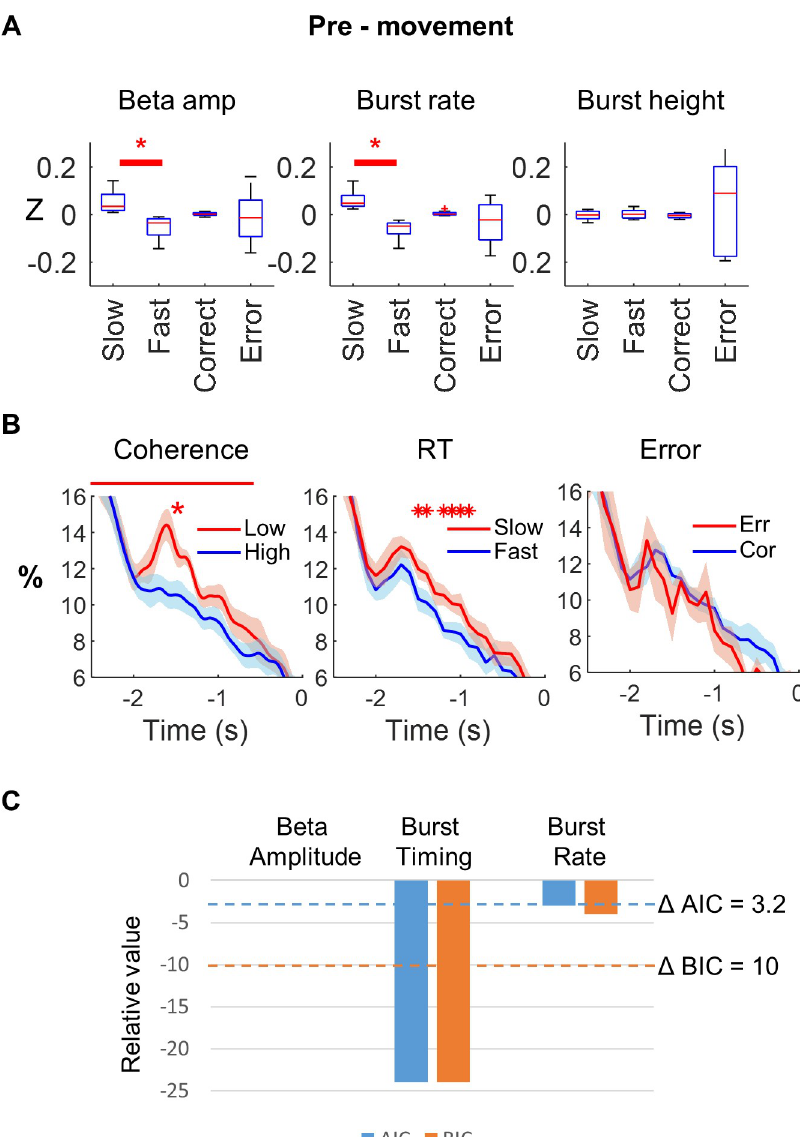
Fig 7. Relationship between beta and motor preparation pre-movement. (A) Pre-movement beta amplitude, burst rate, and burst height, z-score normalised within subject and split according to trials with slow versus fast response times and correct versus incorrect trials ( � p FDR < 0.05). This shows a higher beta amplitude and burst rate on slow trials pre-movement but no effect of upcoming error. (B) Pre-movement burst probability is greater on low coherence than high coherence trials over the RDK period ( − 2.5 to − 0.5 seconds; t (7) = 4.3; p = 0.004; left panel). Burst probability was also higher in trials with a slow versus fast response time between 1,500 ! 900 milliseconds before movement onset (red asterisks, FDR corrected; middle panel), with no effect of upcoming error on burst probability (right panel). On the time axis, zero indicates presentation of the imperative stimulus. Data are down-sampled to 20 Hz. (C) Model comparison of three separate linear mixed effects models incorporating one of single trial beta amplitude (1), beta burst timing (2), and burst rate (3), separately, for response time in the pre-movement period. Δ AIC and Δ BIC model comparison metrics are shown (relative AIC and BIC values compared with those of the beta amplitude model). Conventional thresholds for differences are shown for AIC (blue dashed line: − 3.22) and BIC (red dashed line: − 10), which is equivalent to a 5 × difference in probability of the models or a Bayes factor of 150, respectively. The burst timing model shows a significantly lower AIC/BIC compared with the beta amplitude model ( Δ AIC = − 24) and ( Δ BIC = − 24) for the pre-movement period, confirming that burst timing is a better predictor of response time than average single trial beta amplitude. The underlying data can be found at https://osf.io/eu6nx/. AIC, Akaike information criterion; BIC, Bayesian information criterion; FDR, false discovery rate; RDK, random dot kinematogram; RT, response time.